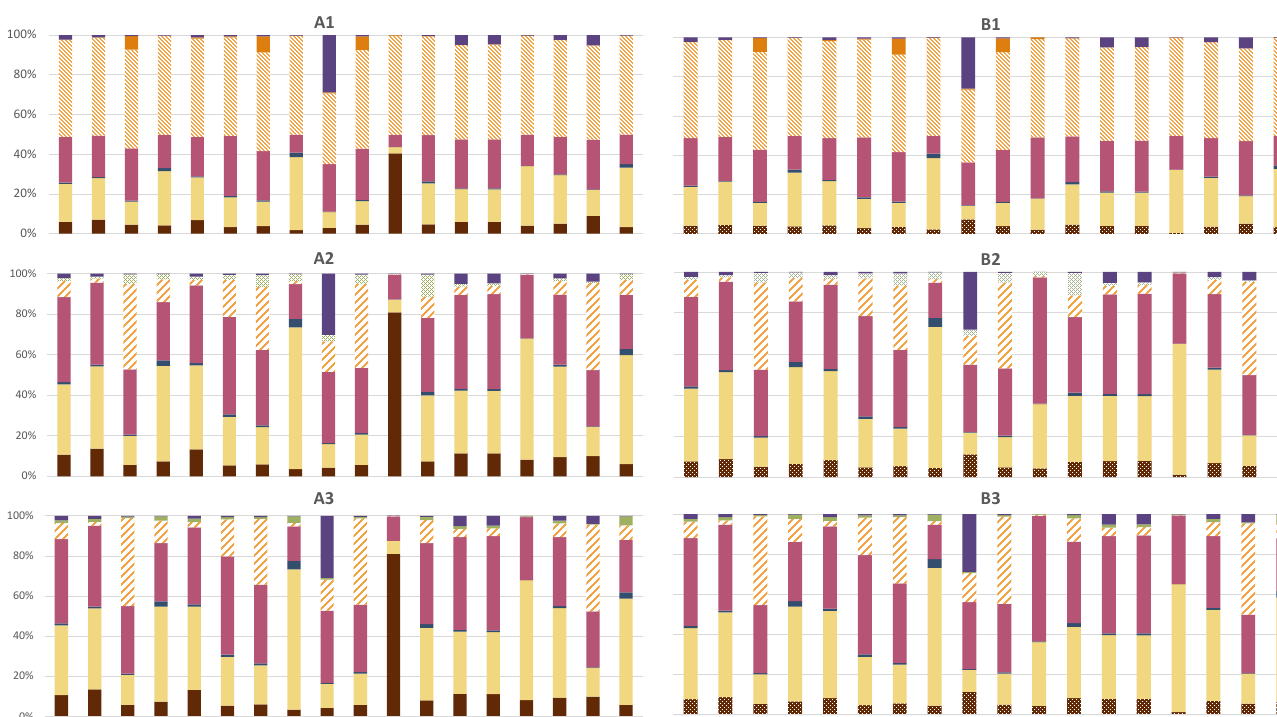
Figure 3. Impactcontribution of the life cycle stages of the product across the impact categories analyzed for the six scenarios. CF production and Manufacturing cover the majority of the impact. This contribution decreases for scenario A1 and B1 because of the substitution . Similar contributions are shown for the synthesis of both curing agents for almost all categories. Limited contributions are observed for Prepreg . Thermal recycling is the only EoL option that covers the majority of the impact for three categories (i.e., A3 and B3).